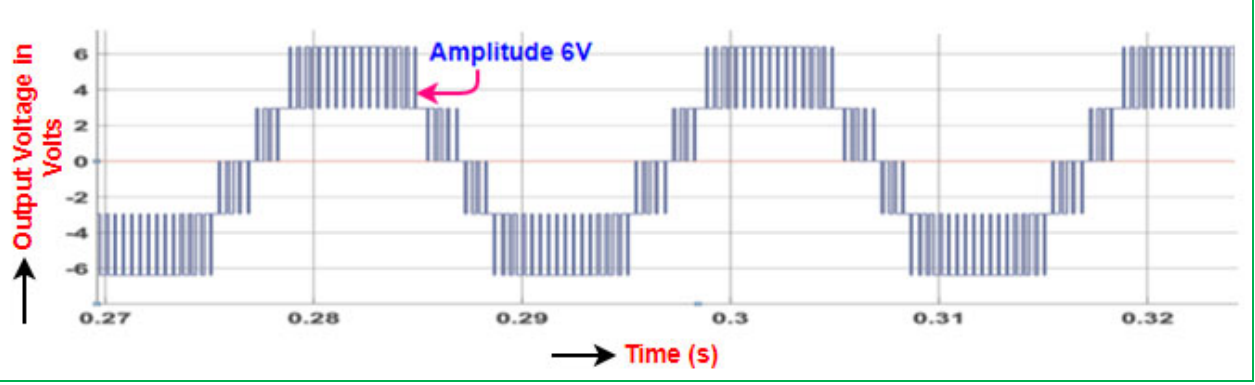
Figure 22. Reduced CMV of cascaded H ‐ bridge MLI using MCSPWM.